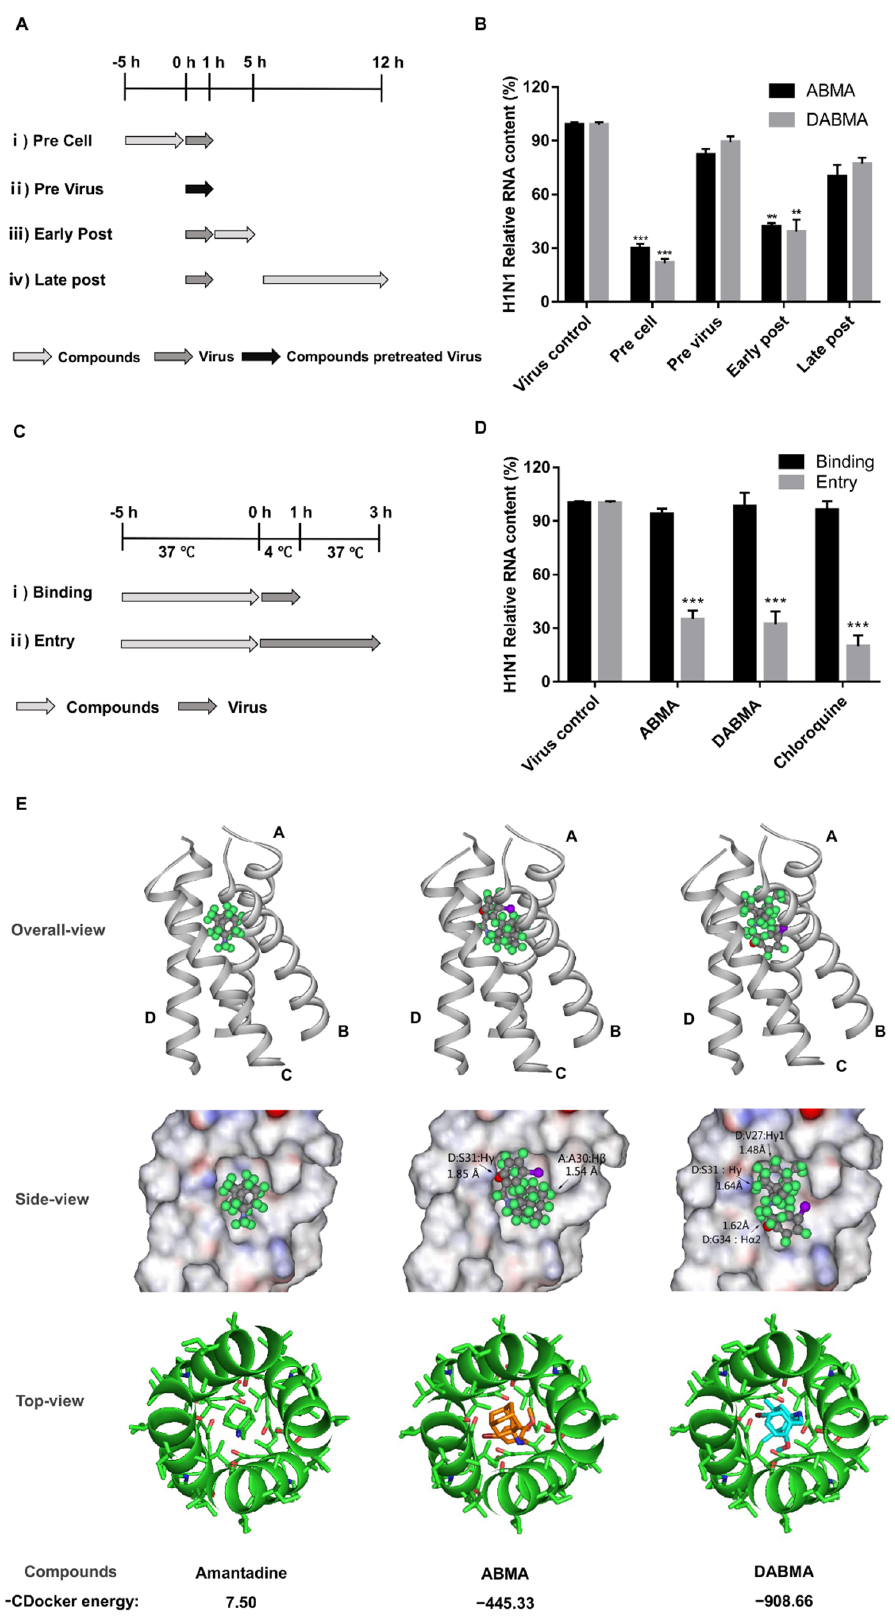
Figure 3. Inhibitory effects of ABMA and DABMA on H1N1 life cycle and M2 channel molecular docking studies. ( A ) ABMA or DABMA treatment of MDCK cells at 15 µM and A/NY/61/LV16A (H1N1, MOI = 1) infection schemes in the time of addition assay. ( B ) Viral RNA was extracted from